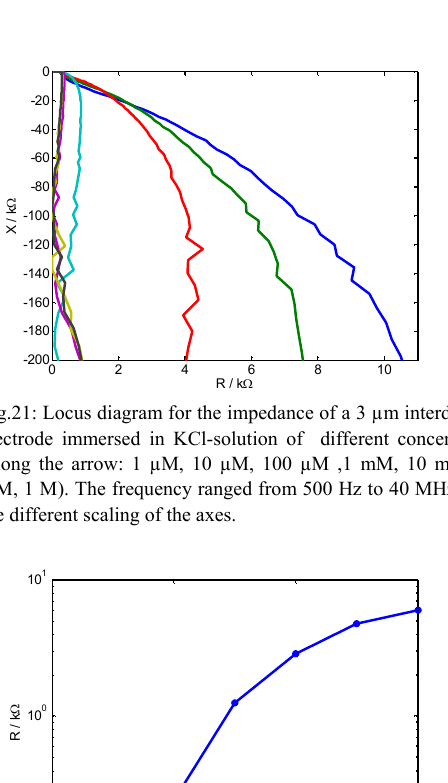
Discrimination of water and oil